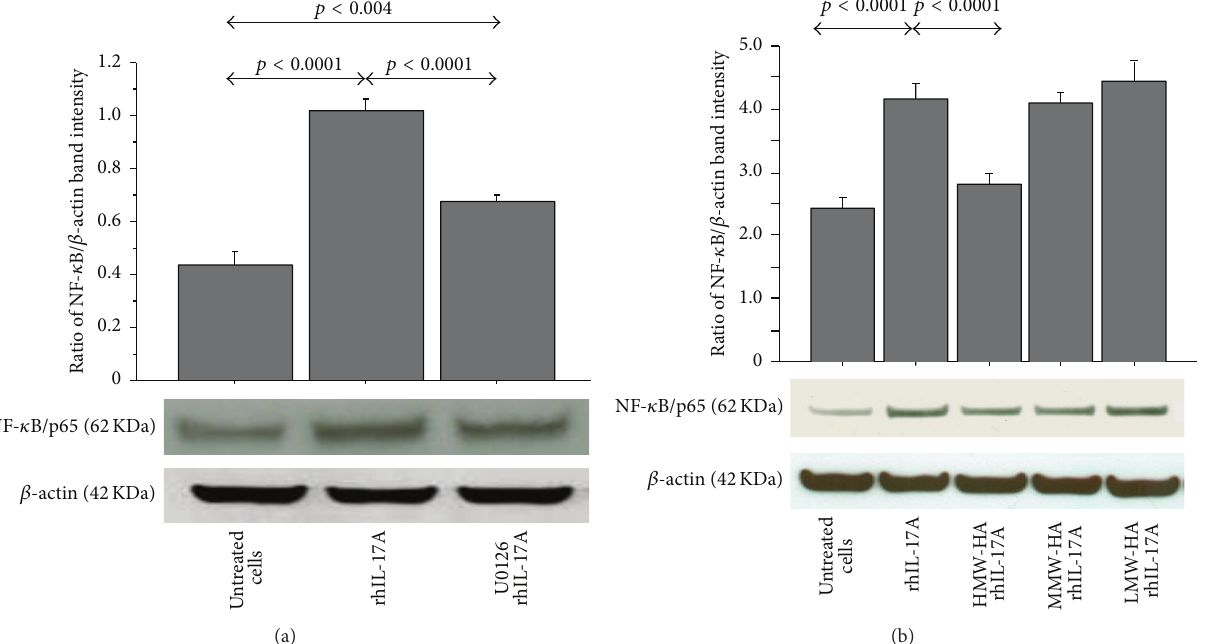
Figure 5: Effect of U0126, HMW-HA, MMW-HA, and LMW-HA on nuclear translocation of NF- 𝜅 B in RPMI 2650 cells stimulated with rhIL-17A. The cells were preincubated (a) with U0126 (25 𝜇 M) or (b) with HMW-HA (100 𝜇 g/mL), MMW-HA (100 𝜇 g/mL), and LMW-HA (100 𝜇 g/mL) for 1 h and then stimulated with rhIL-17A (20ng/mL) for 30min; NF- 𝜅 B was evaluated in nuclear cell lysate by western blot. The bars represent ratio of band intensity and 𝛽 -actin of 3 separate experiments. Representative gel images of NF- 𝜅 B and 𝛽 -actin are shown. ANOVA with Fisher’s test correction was used for the analysis of the data. 𝑝 < 0.05 was statistically significant.